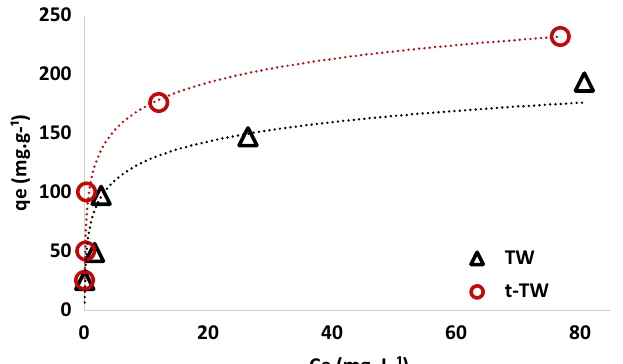
Figure 2. Adsorption of Cr(VI) on tea waste (TW) and ascorbic acid treated tea waste (t-TW). (Contact time: 48 h, initial pH: 6.5, initial Cr(VI) concentration: 100 mg L −1 ; adsorbent dosage: 0.1–4 g L −1 , and temperature: 25